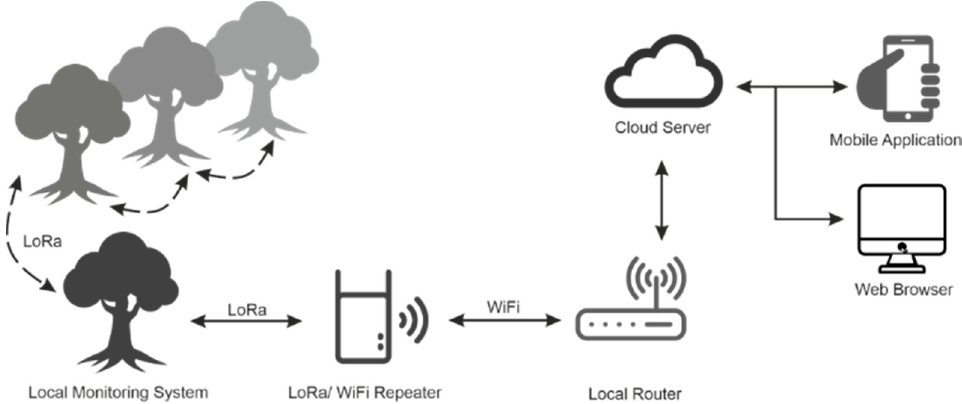
Figure 3. Proposed operating structure.